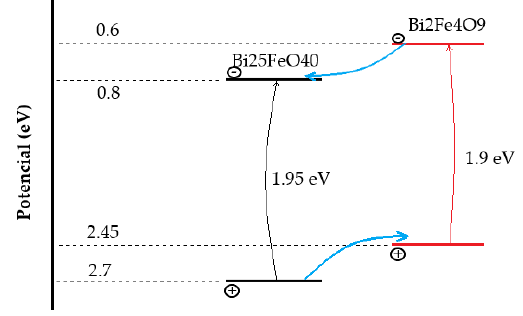
Figure 29. Photocatalytic [98] reaction mechanism of iron Selenite and Mullite under light radiation.